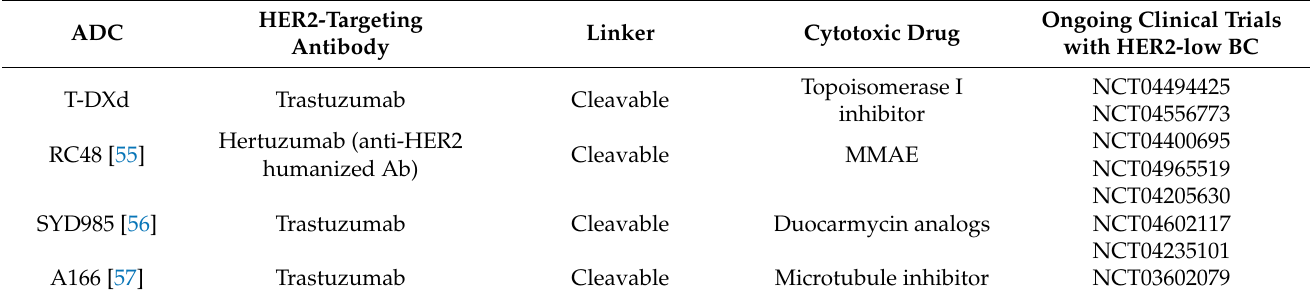
Table 2. Structural characteristics of ADCs in ongoing clinical